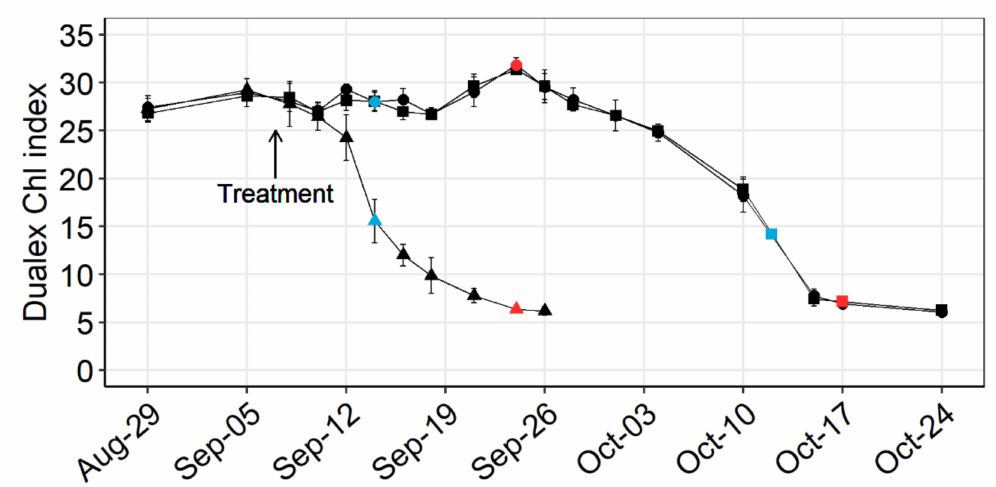
Figure 1. Time course of the Dualex Chl index of Vitis vinifera cv. Riesling leaves: The experimental treatments are control ( • ), ethephon treatment ( (cid:78) ) and natural senescence ( (cid:4) ). The mean values and standard deviations of the three treatments are shown ( n = 4). Sampling events for RNA sequencing and amino acid analysis are marked in blue, those for leaf N analysis in